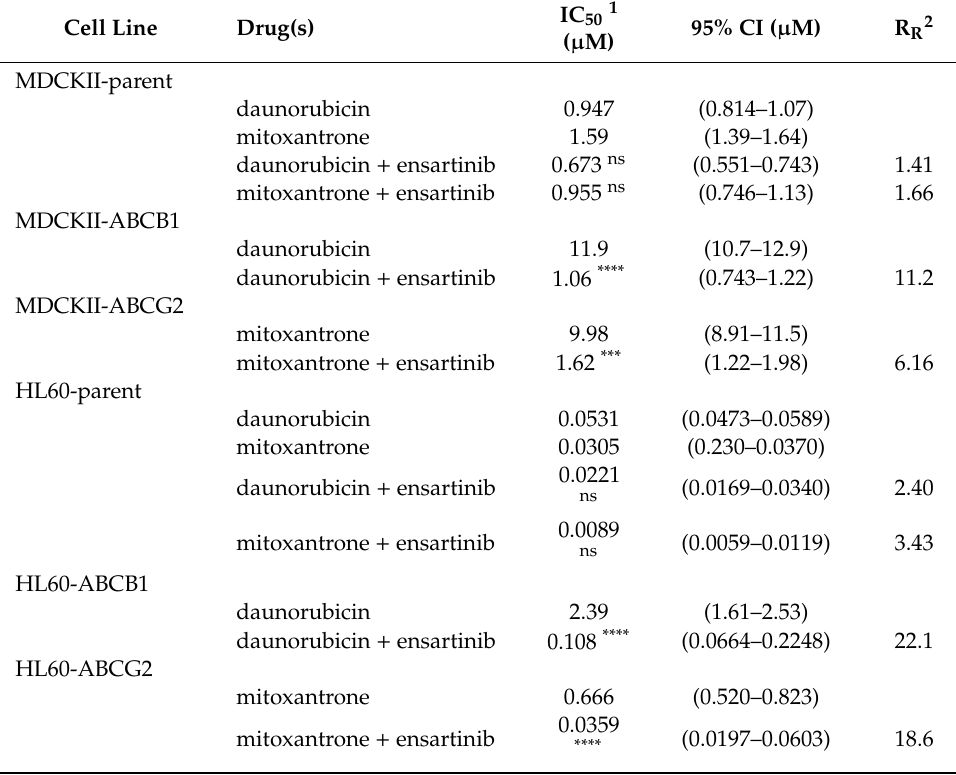
Table 1. IC 50 -shift analysis of the combination e ff ects of ensartinib (10 µ M) with the cytostatic substrates daunorubicin or mitoxantrone in MDCKII and HL60 cell